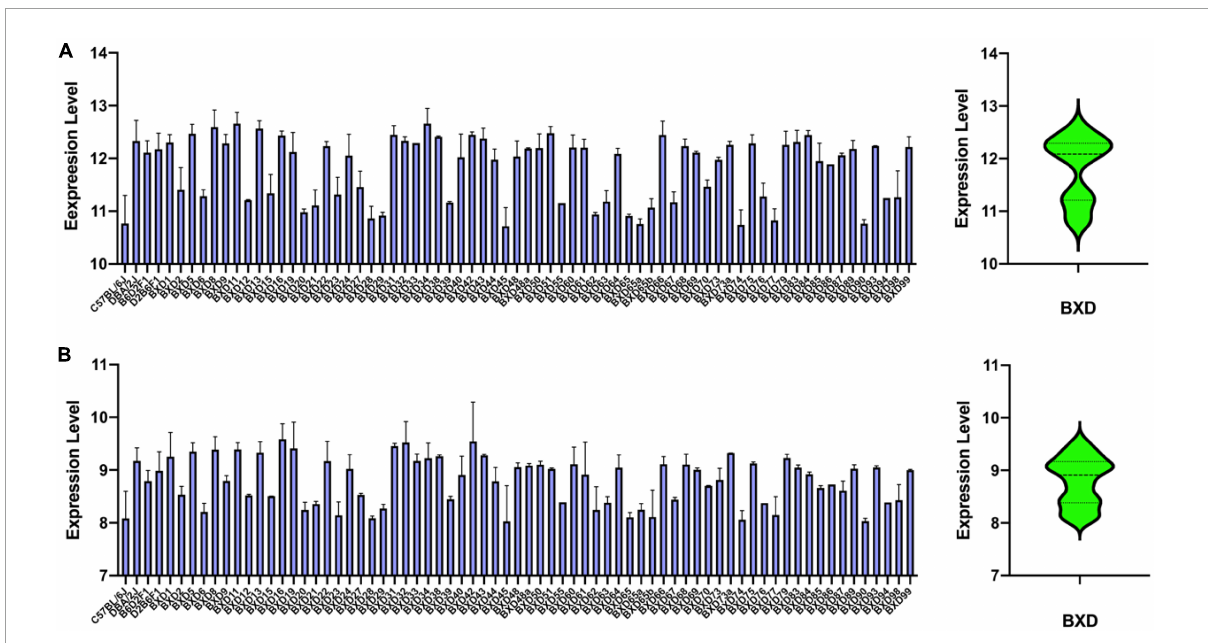
FIGURE3 Bar and violin plots showing the Lpl expression variation across the BXD hippocampus. A total of 71 strains were employed for hippocampal transcriptomic profiling, with two probes 1415904_at (A) and 1431056_a_at (B) , representing the Lpl expression level. The values are log2 transformed, and mean ± SE was used.